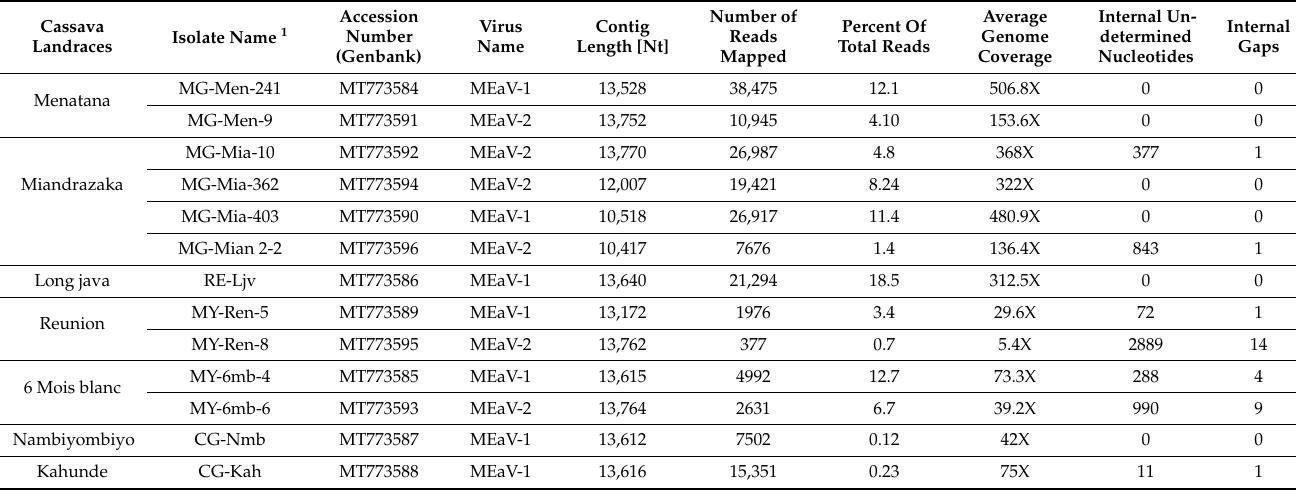
Table 4. Lengths, number of reads integrated, percent of total reads and average coverage for Closteroviridae contigs from the various analyzed cassava